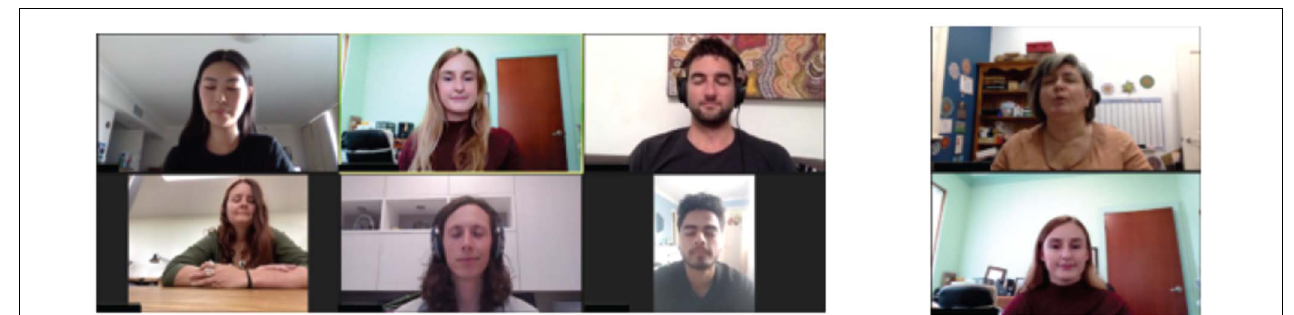
FIGURE 5 | Example of group and individual